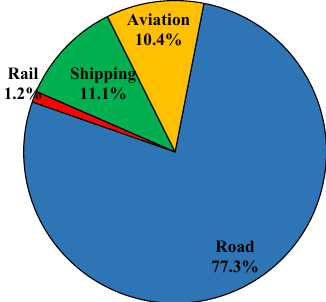
Figure 2. Breakdown of CO 2 emissions in the transportation sector [2].